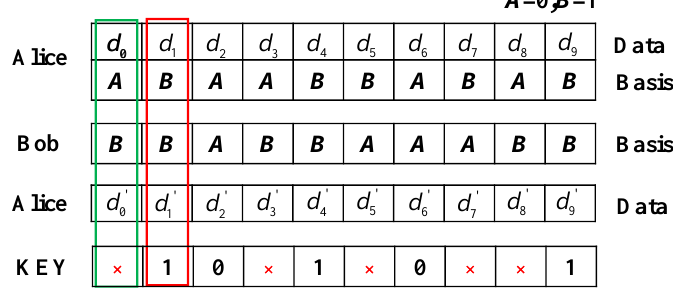
Figure 3. Generate the key schematic.